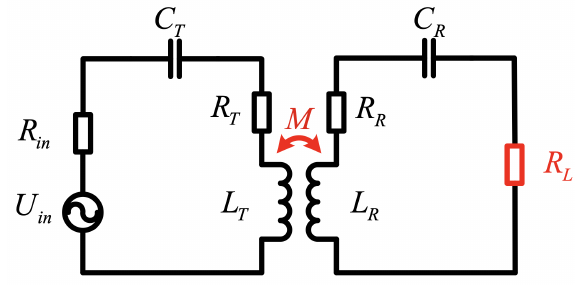
Figure 11. Mutual inductance L M and load R L